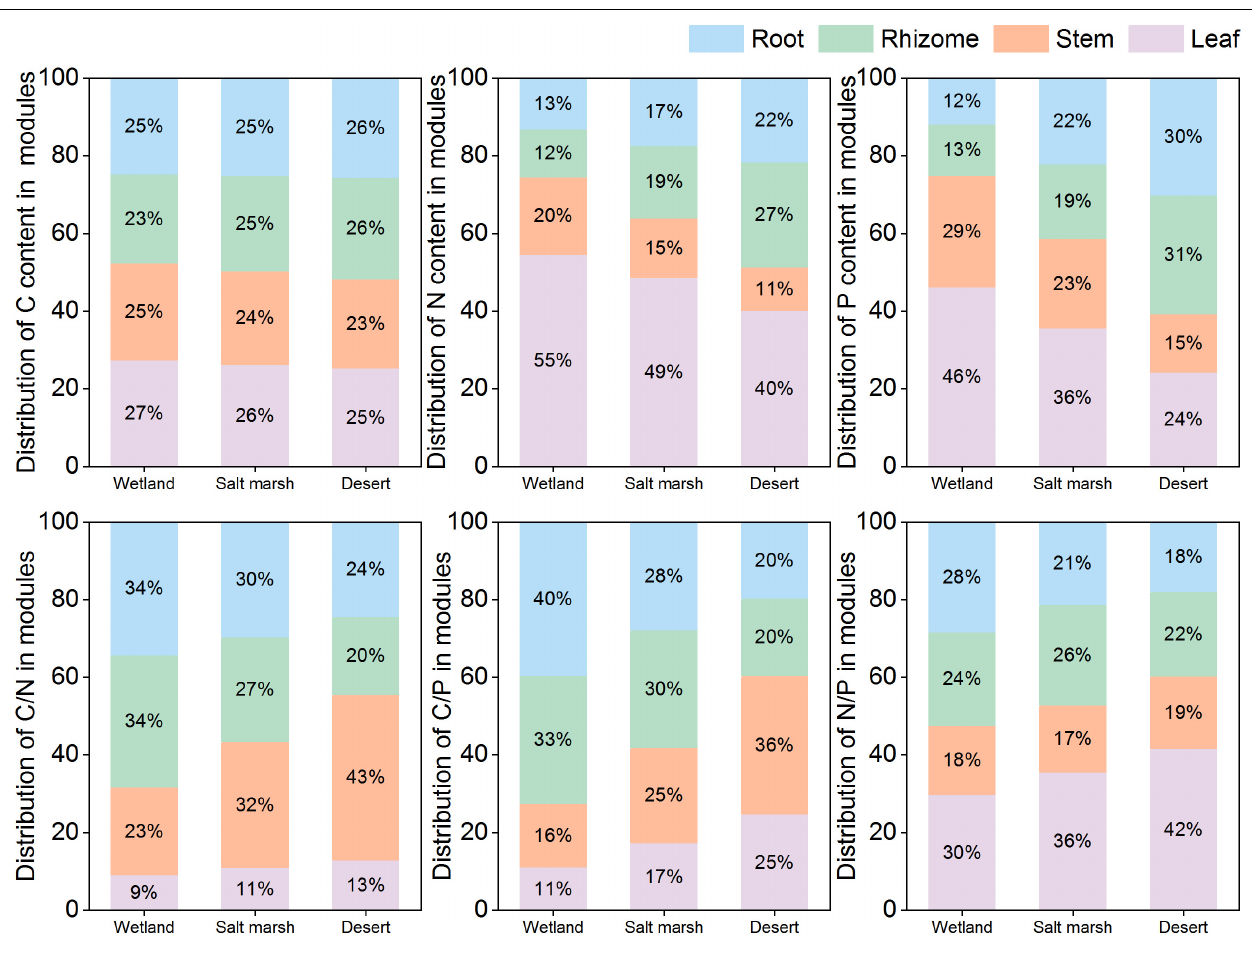
FIGURE 4 | Modules allocation of stoichiometry of P. australis in different